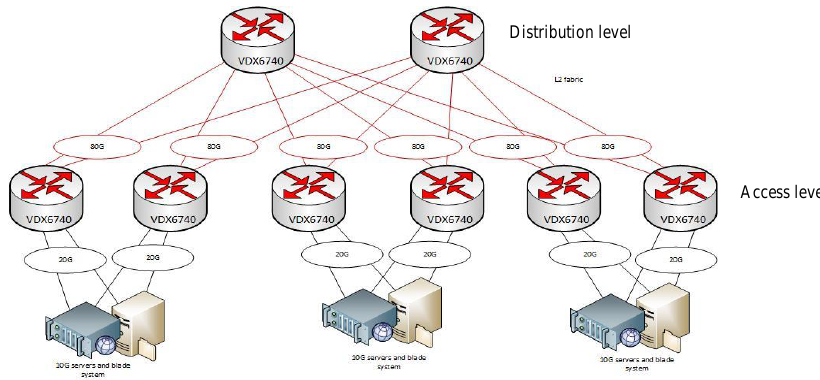
Fig. 1. A three-tier model of network segment Tier1 in the